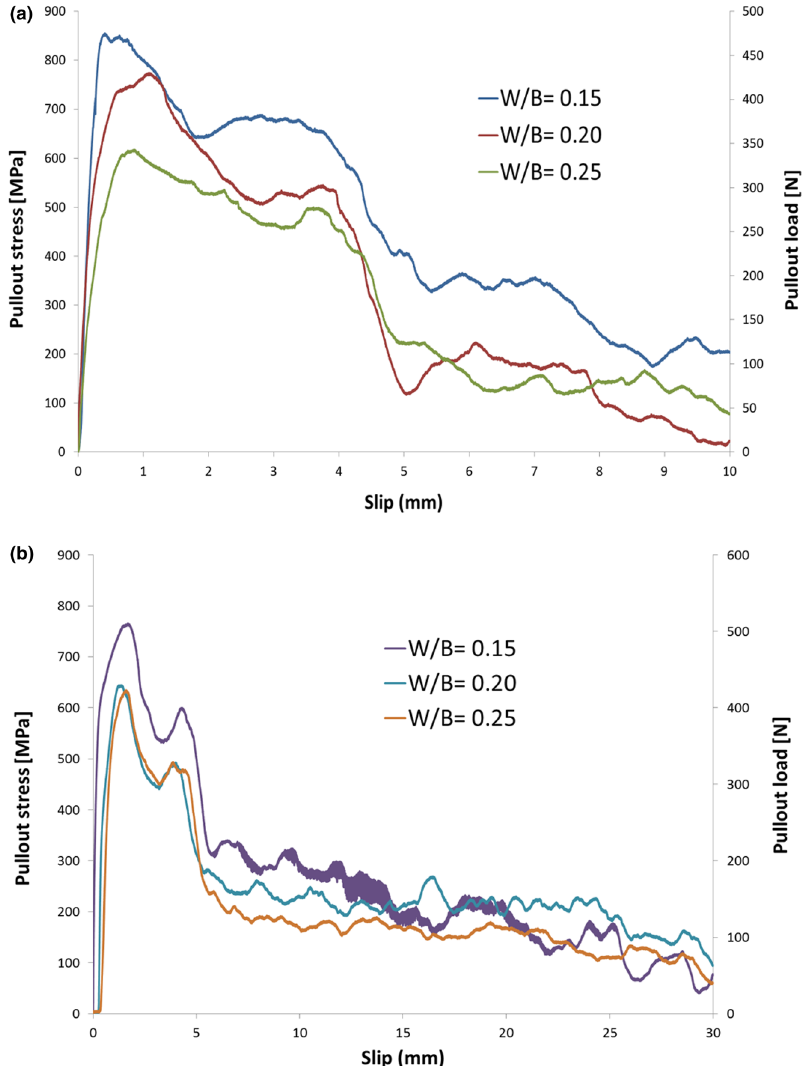
Fig. 7 Average pullout load-slip curves of 3DH2 fibres. a embedded length (10 mm), b embedded length (30